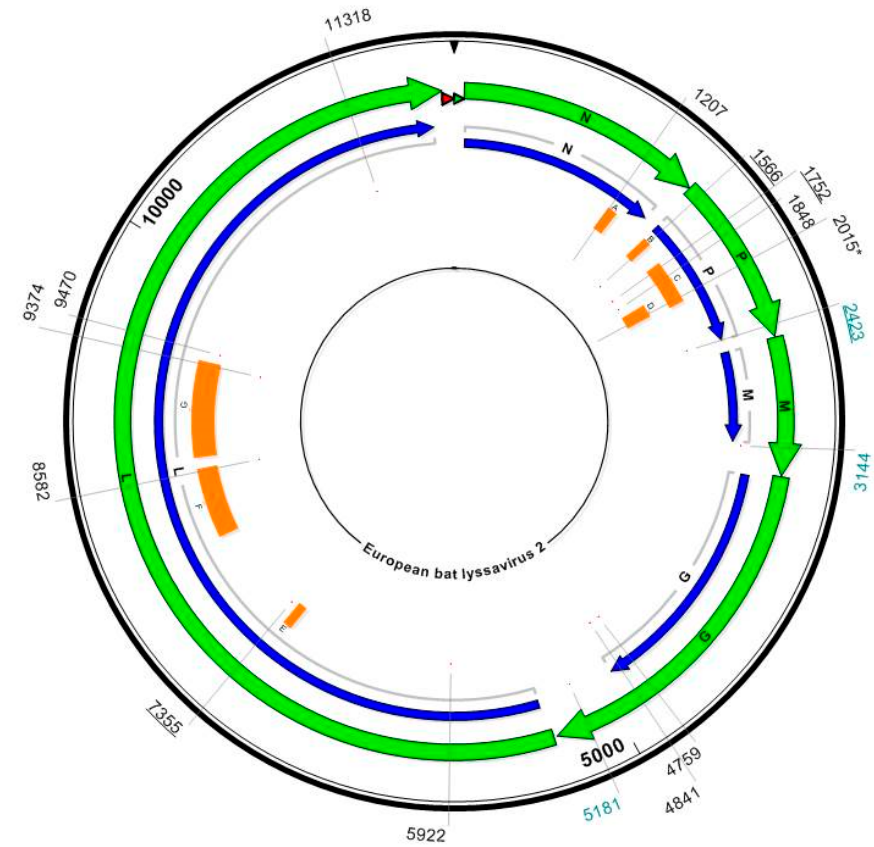
Figure 4. A circular map of the EBLV2 genome. Numbers indicate genomic positions at which heterogeneity is seen between the three genomes from Stokesay Castle. Black positions are located within coding regions, teal positions are in non-coding regions. Position 2015 (asterisk) has a base change corresponding to an amino acid substitution. Orange blocks indicate known domains within each protein where heterogeneity between the three genomes is observed. Underlined positions indicate those at which >1% heterogeneity is seen within the host. Domains key: A = T-cell epitopes; B = L binding region; C = soluble N binding region; D = LC8 protein binding region; E = Domain III; F = Domain IV; G = Domain V.